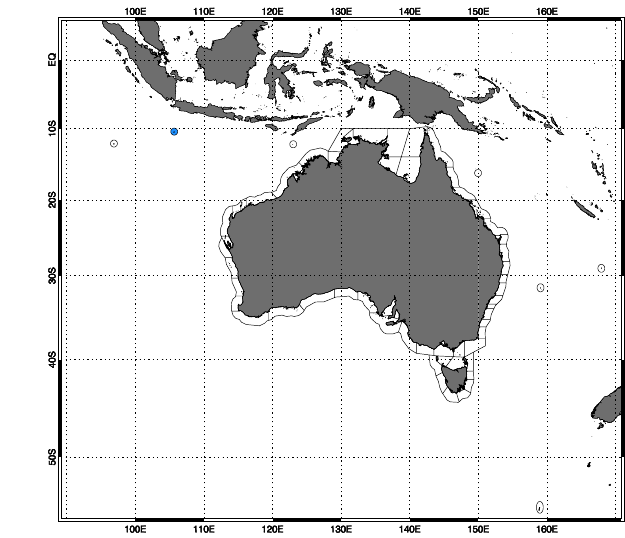
Fig. 11. Derived T2 warnings for the Sumatra 2005 event based on the thresholds in Sect. 3.2. Coastal zones assigned a marine threat are shaded in blue.